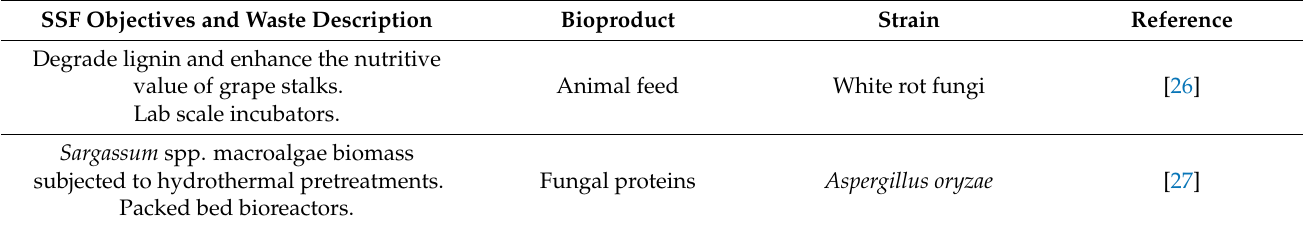
Table 1. Compilation of the nexus organic waste(substrate)/strain/bioproduct used recently in